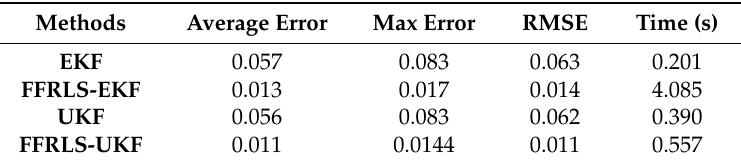
Table 2. Comparison of Algorithms without measurement